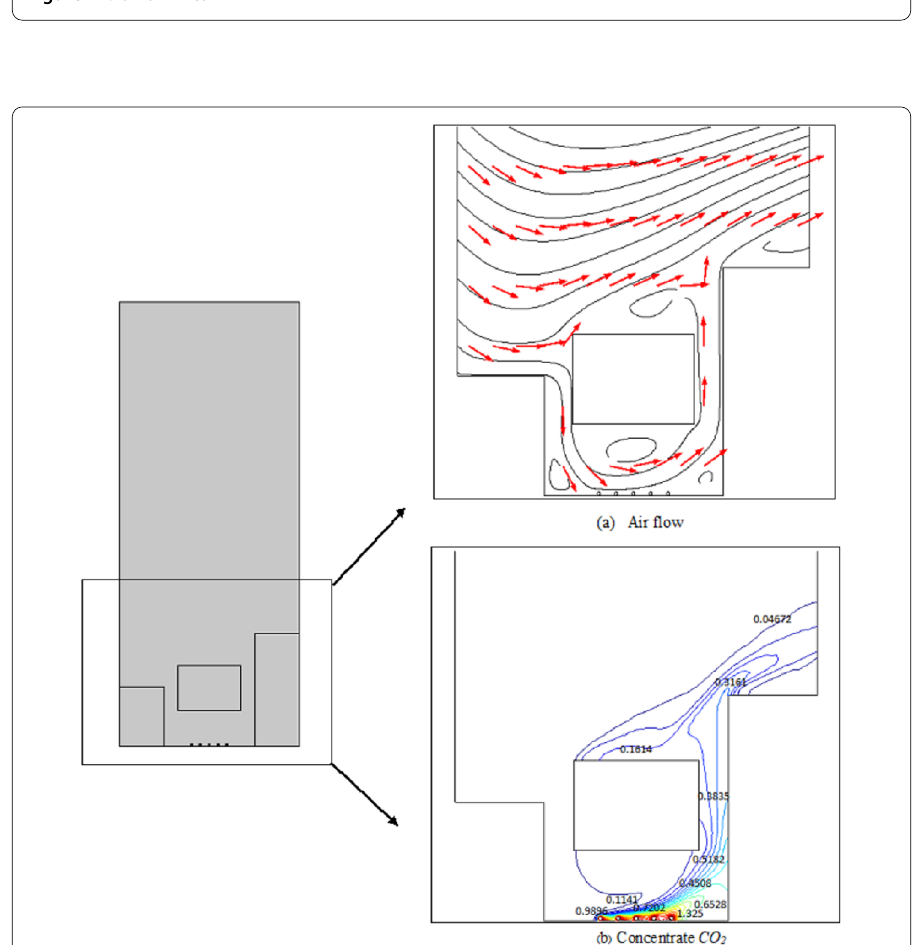
Figure 3 Velocity field and streamlines of wind and contour lines of CO 2 concentration obtained from the model with the inlet wind magnitude of 5.40 knots (10 km/h) and the wind blowing from the southeast